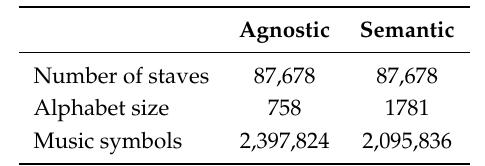
Table 2. Composition of PrIMuS dataset in terms of number of samples (staves), size of the alphabet, and number of symbols with respect to the different representations.